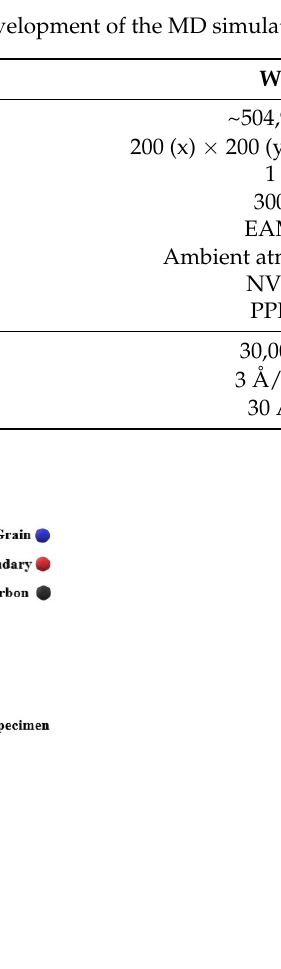
Figure 1. A simulation model can be created to illustrate the nanoindentation process in three dimensions using a spherical indenter as a representative example, where the particles colored blue, red, and black represent grain, grain boundary, and carbon atoms, respectively.